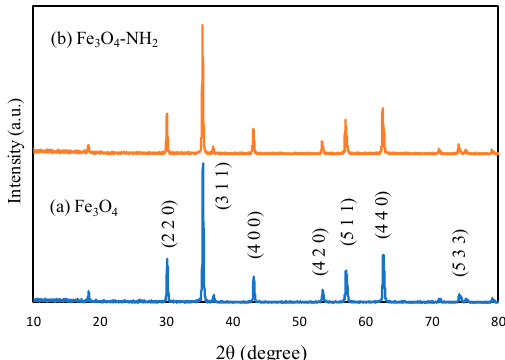
Figure 5. X-ray diffraction (XRD) pattern of ( a ) bare Fe 3 O 4 and ( b ) aminosilanized Fe 3 O 4 .